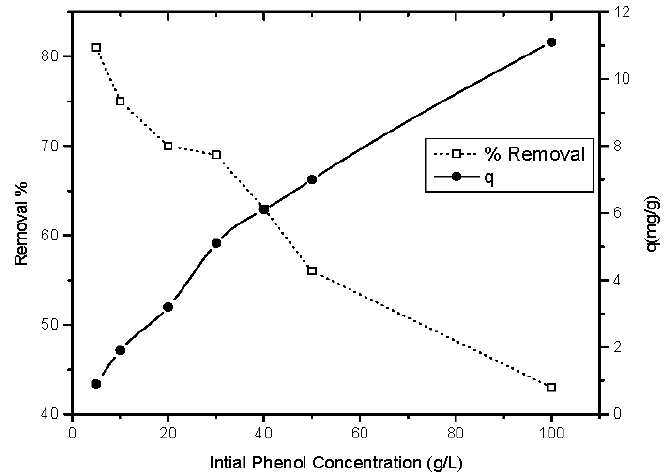
Figure 8. Influence of initial phenol concentration on both the percentage of phenol removal and phenol uptake capacity on to magnetic ZnO nanotubes (pH = 5, material dosage = 2 g/L, agitation speed = 440 rpm, contact time = 90 min and temperature = 25 °C).